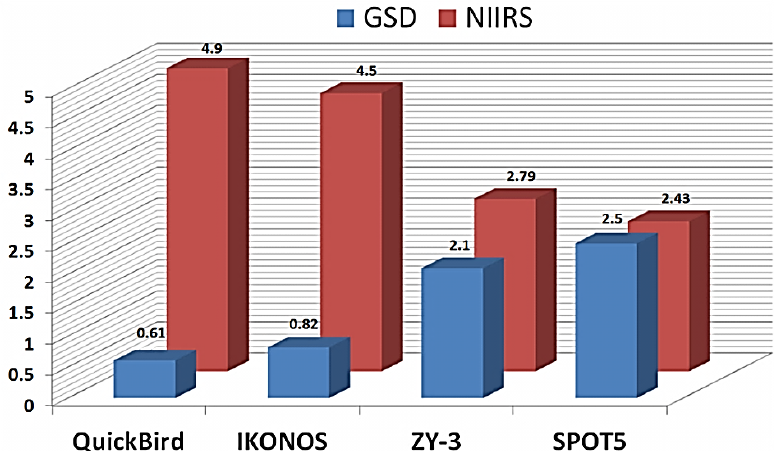
Figure 8. Comparison of the GSD and NIIRS of different satellite